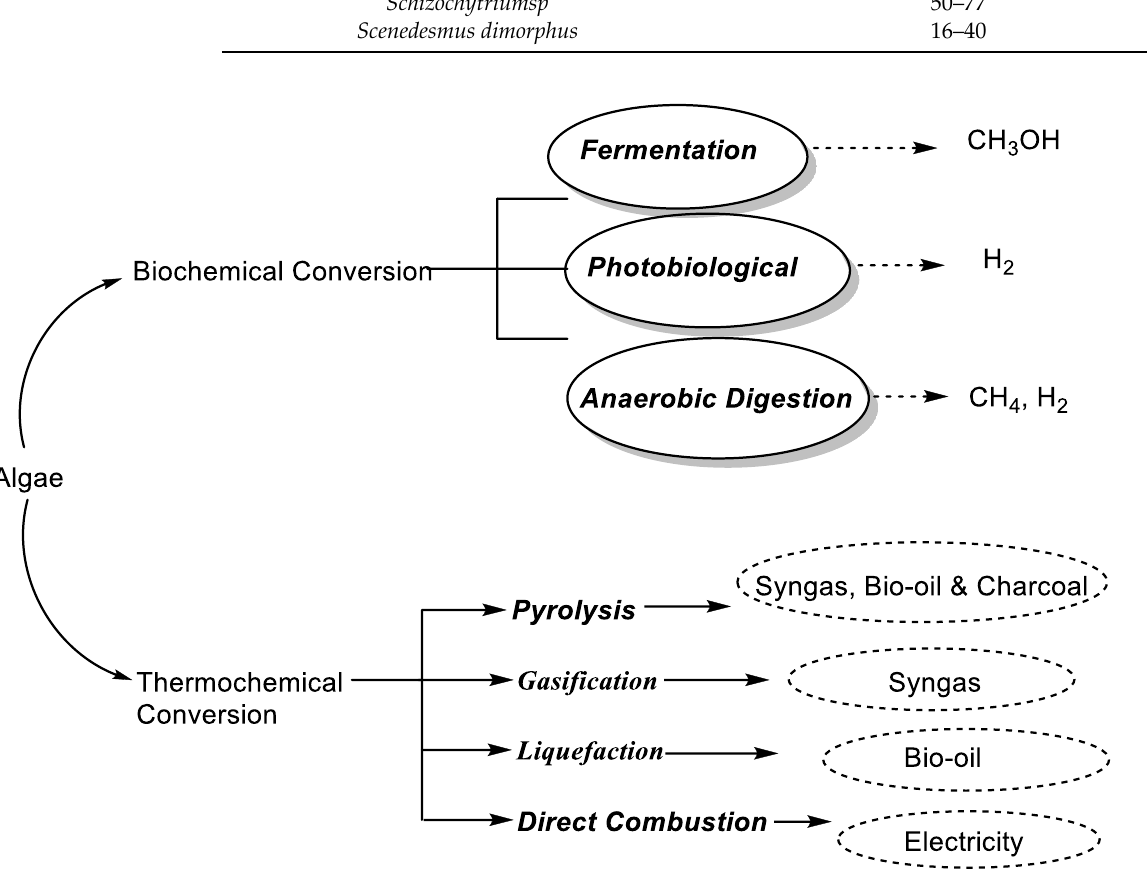
Figure 1. Algae biomass conversion process.